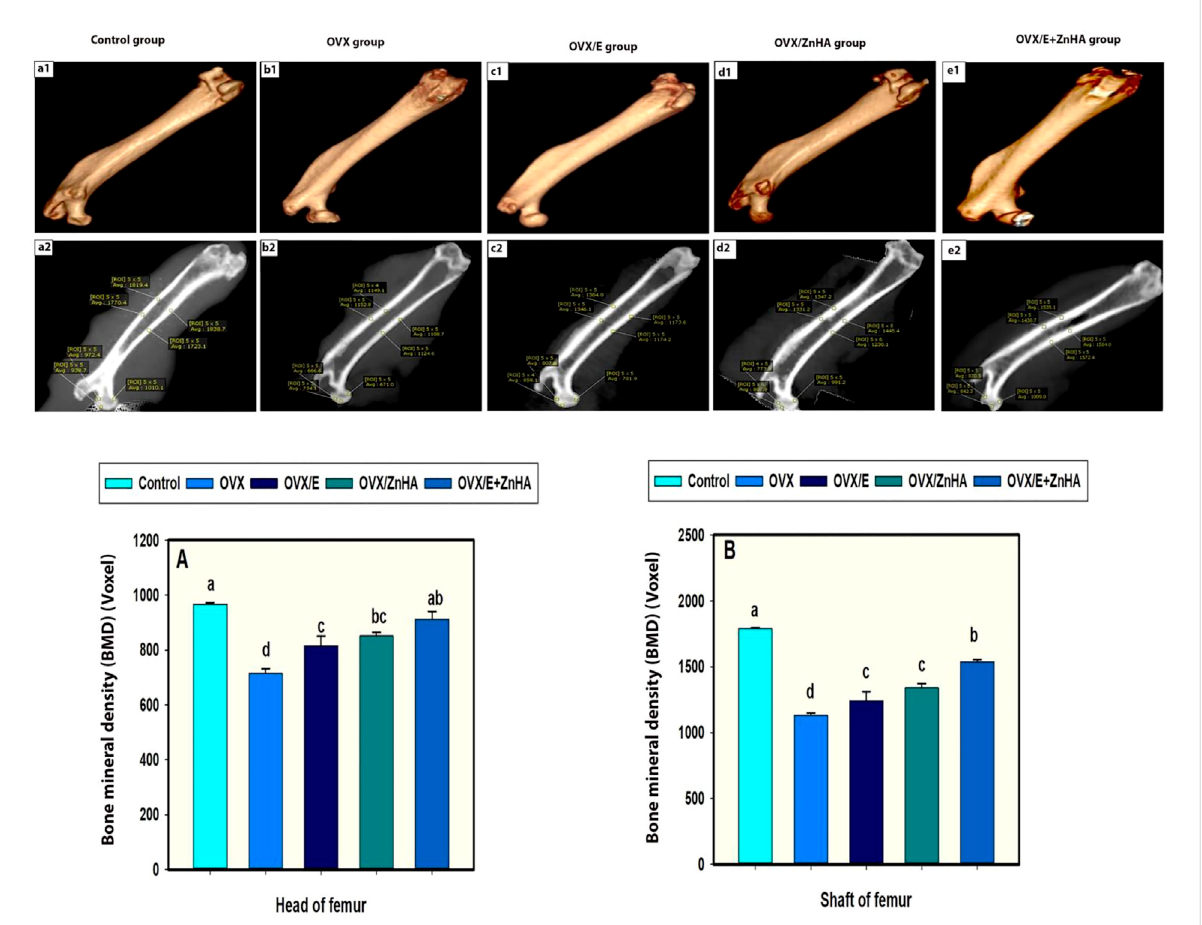
FIGURE 8 a1,b1,c1,d1ande1representthree-dimension imageoffemurwithinanimalgroup.a2,b2,c2,d2ande2representing Averageofbonemineral densities of both shafts and heads of femurs. (BMDs were measured in a region of interest [ROI) 5 x 5 voxels. Data of BMDs in head of femur (A) and shaft (B) expressed as Mean ± SEM. The different letters indicate signi fi cant differences ( p < 0.05) among between experimental